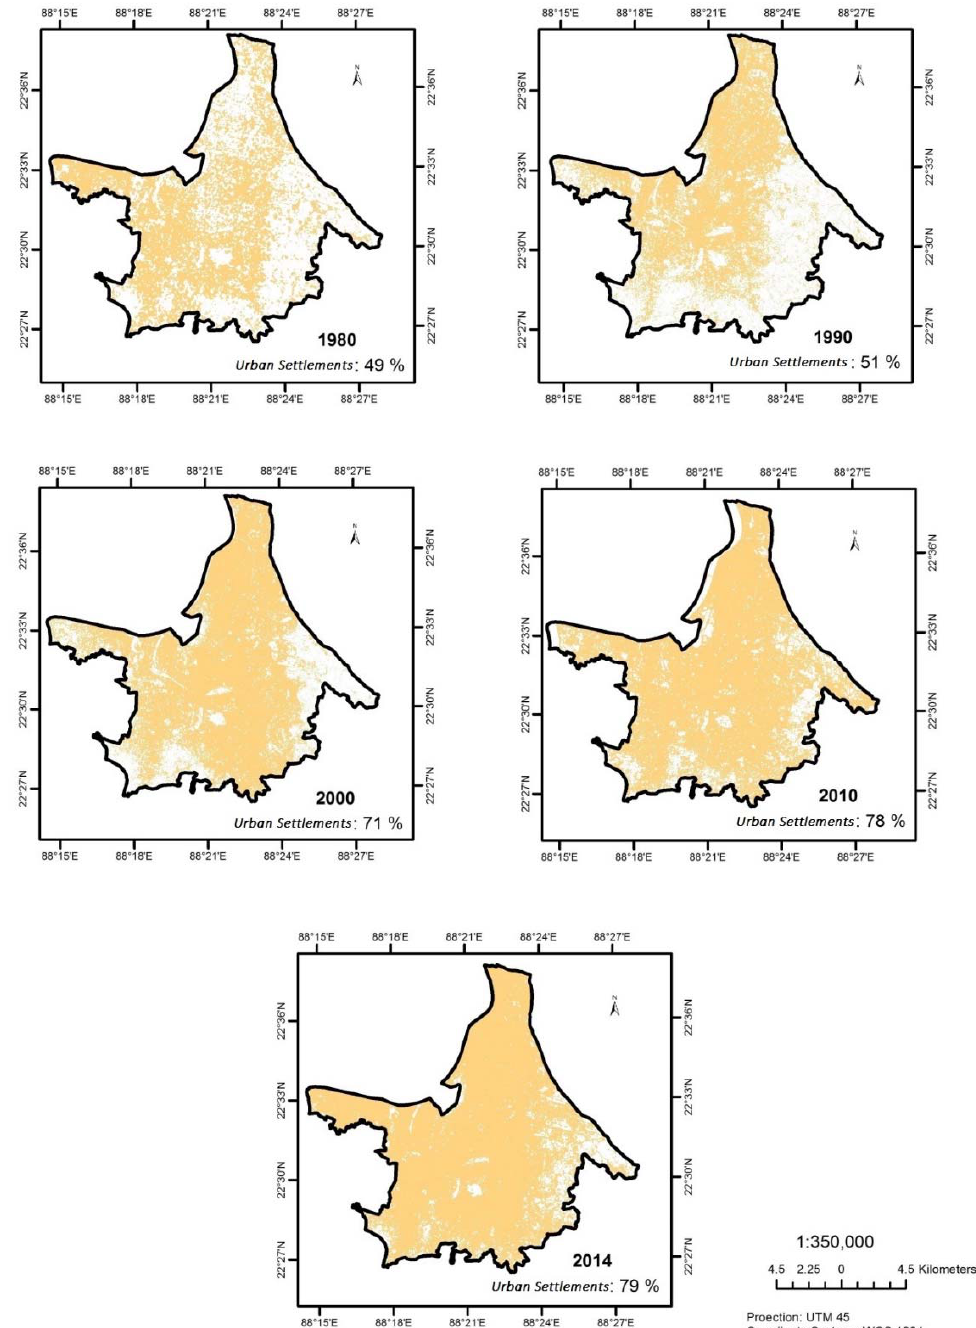
Figure 4. Distribution of urban settlements (brown patches) within Kolkata Municipal Corporation area (KMC) in time slices from 1980 to 2014 (decade-wise) (Data base courtesy: Satellite Image interpretation from Landsat (USGS) and LISS III series (ISRO, India) and the Govt. of West Bengal, India).